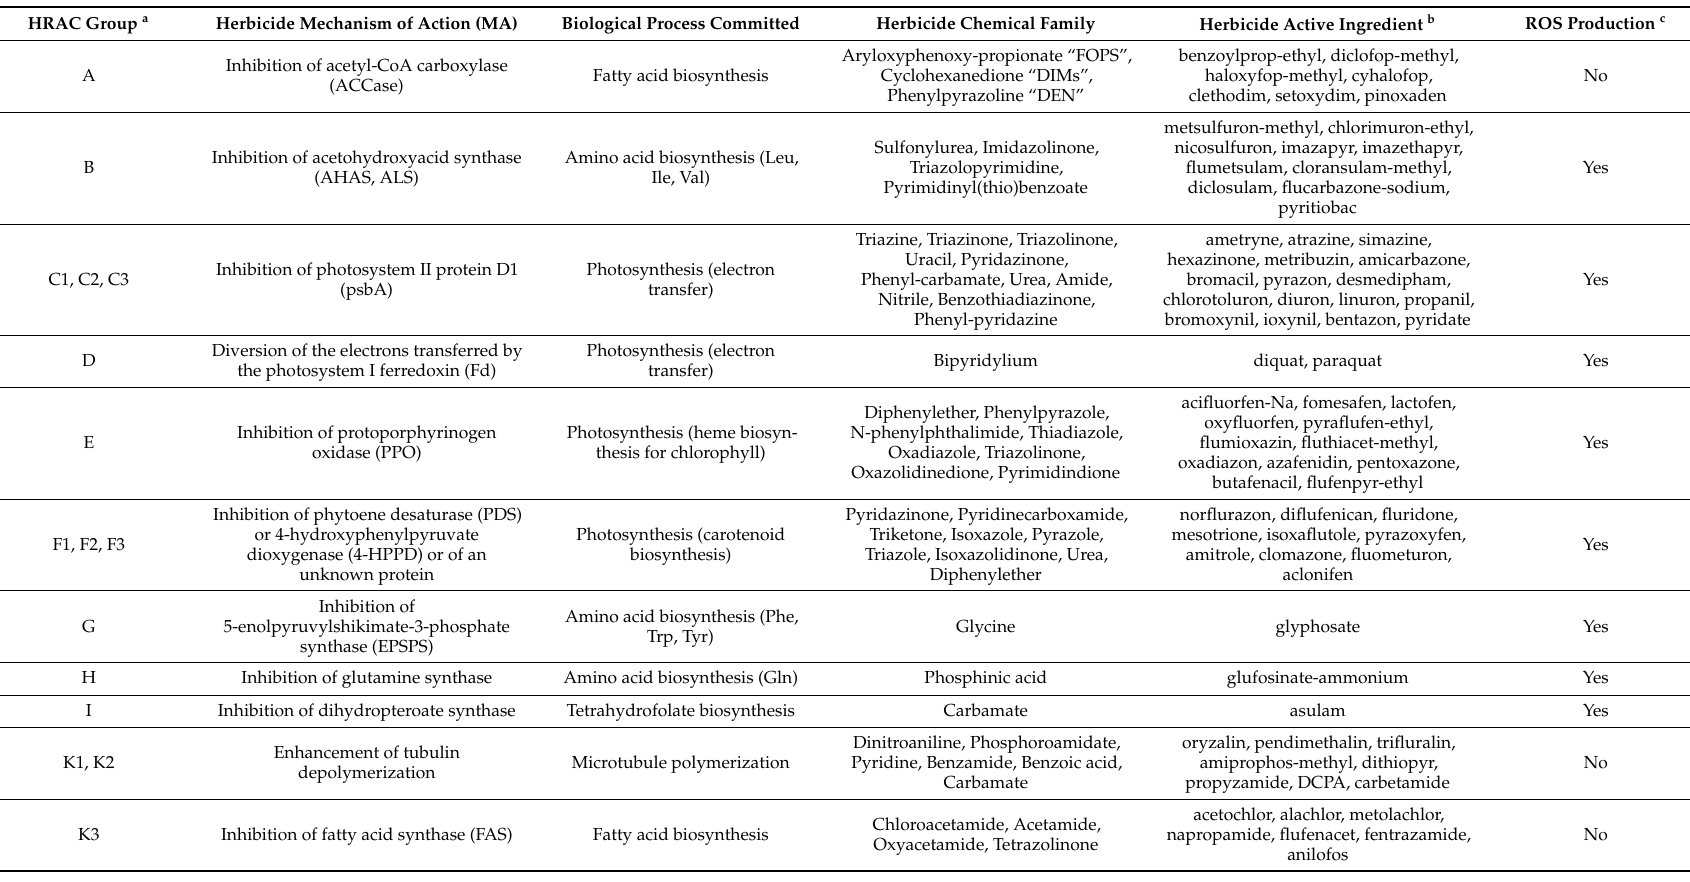
Table 1. Description of the herbicide mechanisms of action (MA) and their effects on treated plants related to the production of reactive oxygen